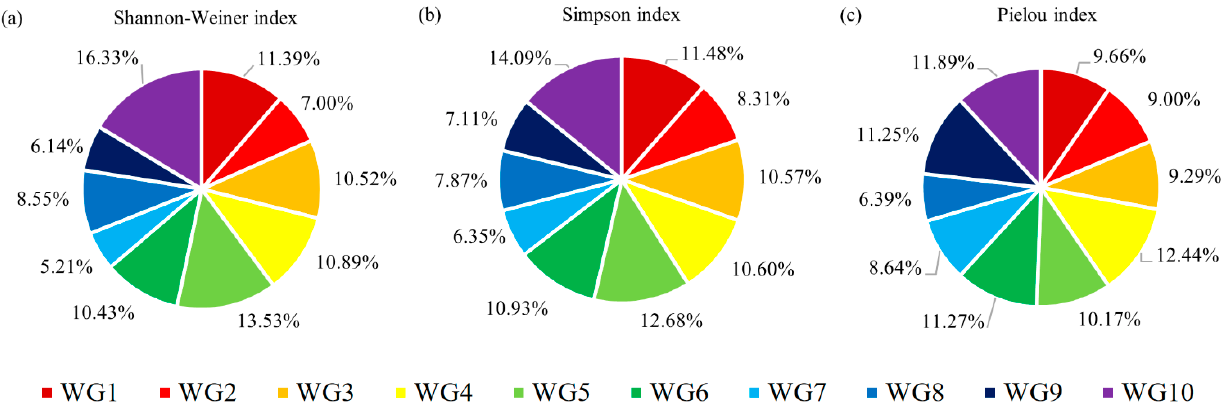
Figure 2. The groundwater level characteristics of 10 monitoring wells.